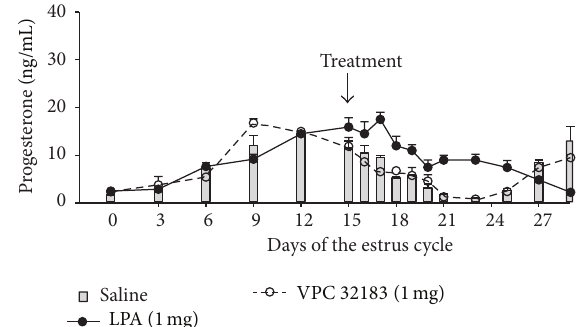
Figure 2: Concentrations of progesterone in peripheral blood plasma of heifers infused with saline (grey bars), LPA (1mg; line), or LPA (1mg) together with blocker of LPARs (VPC32183; 1mg; dotted line) on day 15 of the estrous cycle. (Adapted from